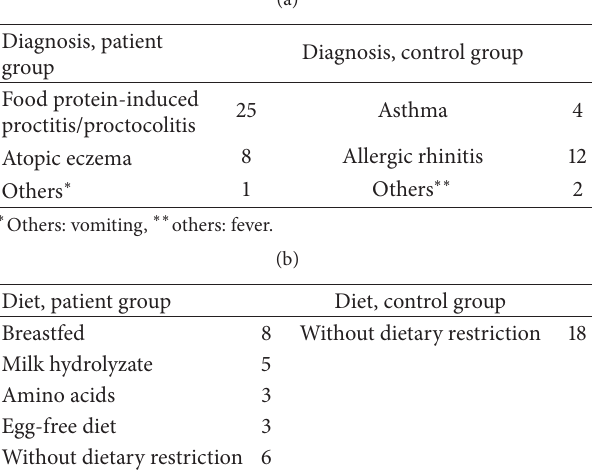
Table 1: Diagnosis and dietary regime of patients and